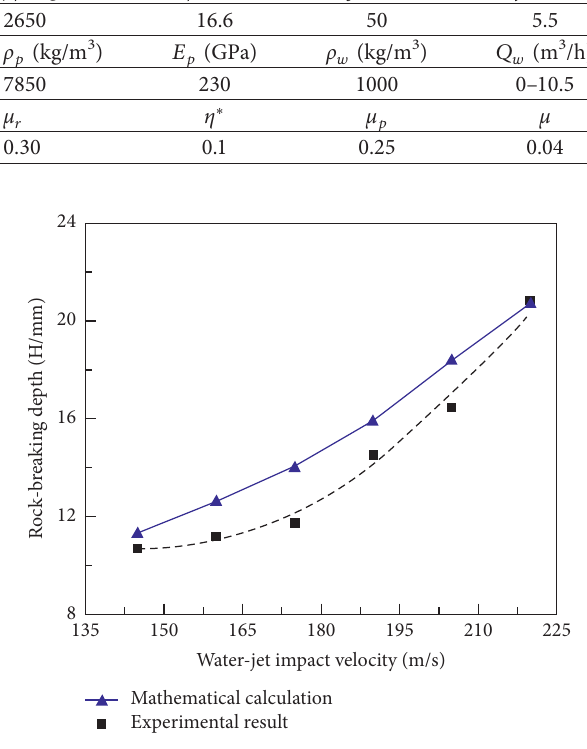
Figure 7: Effect of water-jet impact velocity on rock-breaking depth (test time with 10s; particle diameter with1.0 mm; impact angle with 0 ° ).